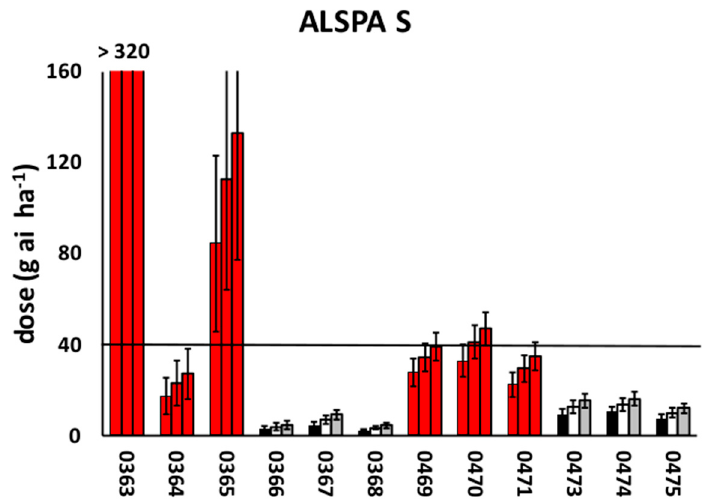
Figure 4. Estimation of ED 50 , ED 80 , and ED 90 (ED 50 black bars, ED 80 white bars and ED 90 grey bars) of penoxsulam for plant survival (S) of populations of Alisma plantago-aquatica (ALSPA). Red bars indicate populations resistant to SUs according to the preliminary screenings. Population 0363 is an ALS-resistant check. Vertical bars represent 95% Confidence Intervals. Recommended field dose of penoxsulam (40 g ai ha − 1 ) is represented by the horizontal black line. Table 2. Values of effective dose for 50% and 80% estimated plant survival (ED 50 and ED 80 ) and fresh biomass reduction (GR 50 and GR 80 ) of Alisma plantago-aquatica (ALSPA), Cyperus difformis (CYPDI), and Schoenoplectus mucronatus (SCPMU).